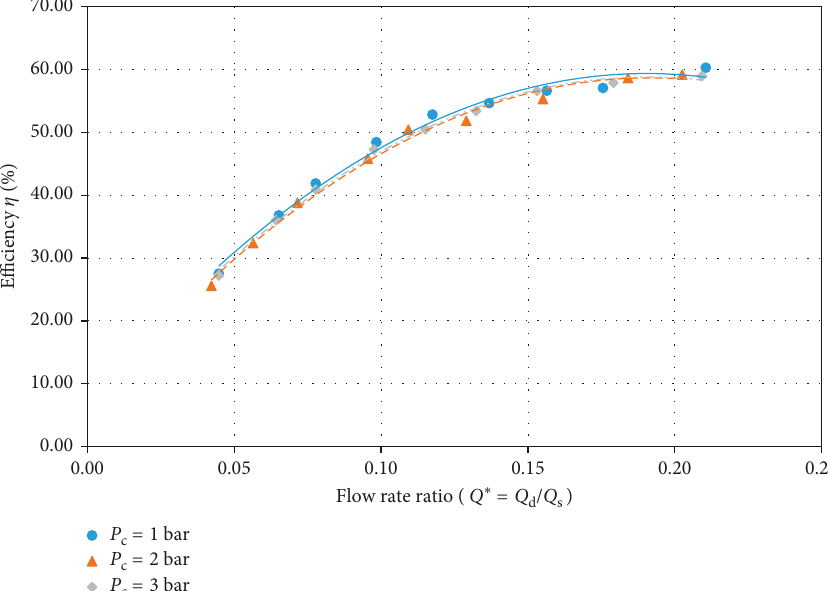
Figure 9: Efficiency vs. flow-rate ratio at difference pressure inside the air chamber, P